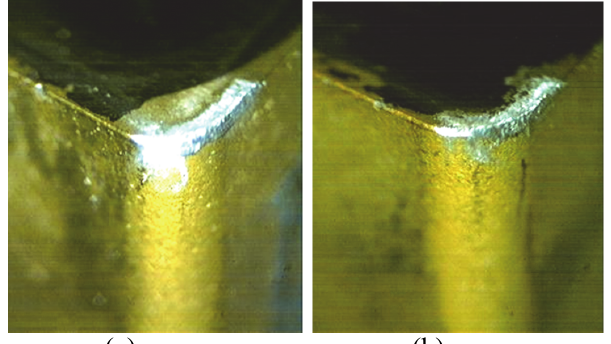
Fig. 10. Worn cutting edges at V=206 m/min, f=0.05 mm/rev and d= 0.5 mm during turning in (a) dry